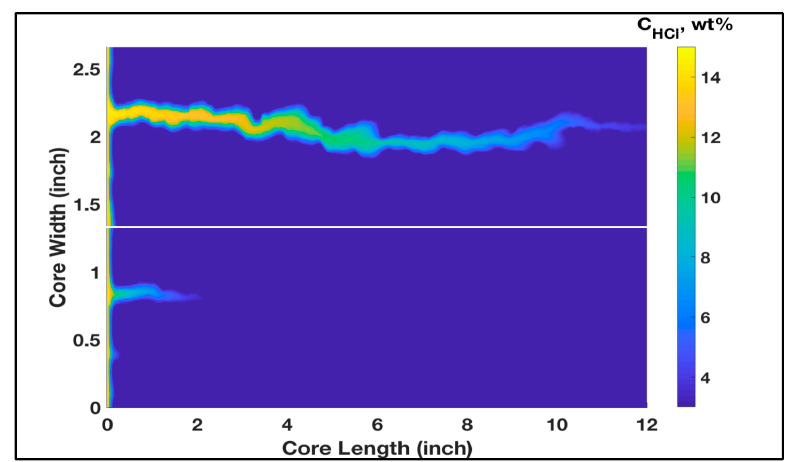
Figure 5. Concentration profile at the breakthrough for the HCl acid treatment with no diversion, showing a wormhole growing mainly in the high-permeability core sample.